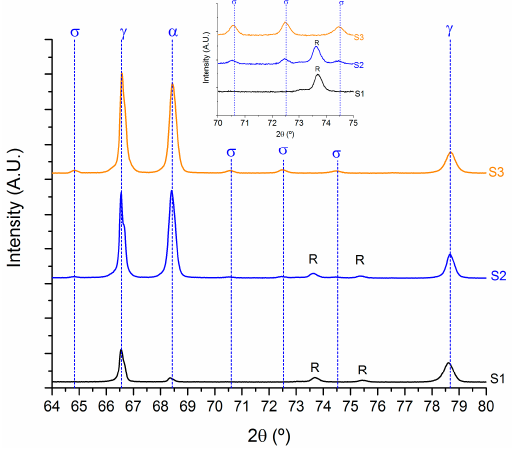
Figure 1. X-ray diffraction patterns for samples from S1 to S3 using a Cr source ( λ K α 1 = 2.2897 Å). The “R” symbols refer to some peaks coming from the resin where samples S1 and S2 are hot mounted.